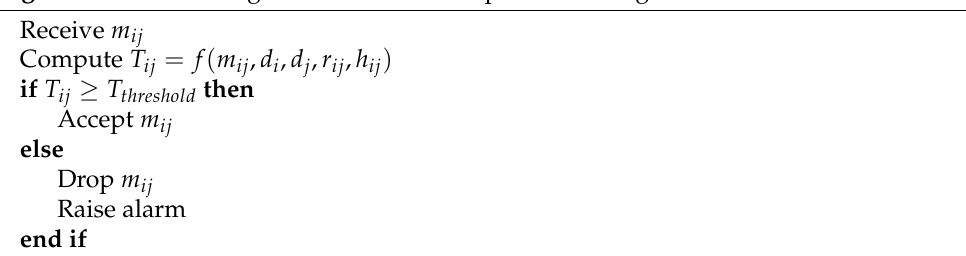
Algorithm 1 Pseudo-algorithm for trust computation for agent device